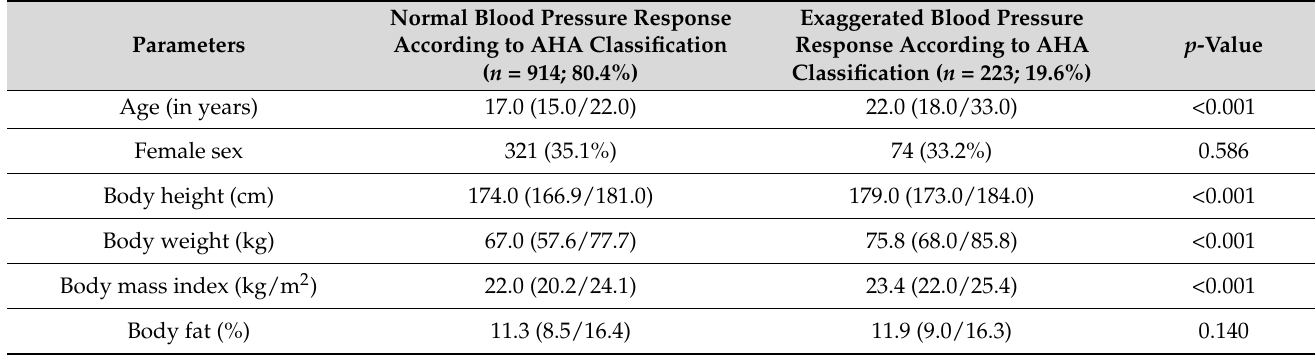
Table 1. Patient characteristics of the 1137 examined athletes without known arterial hypertension stratified for exaggerated blood pressure response according to AHA guideline.